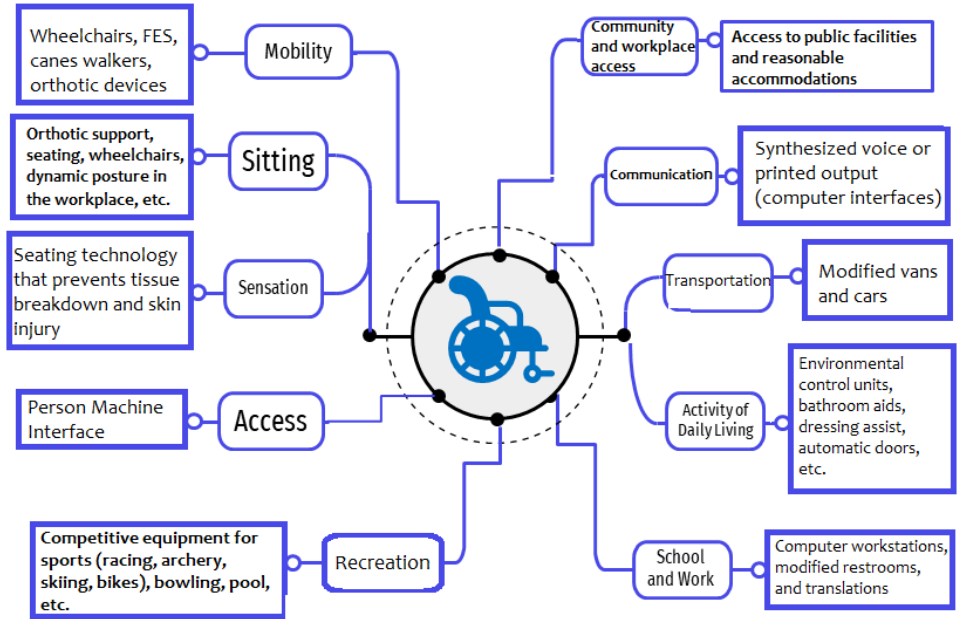
Figure 6. Specific impairments and related